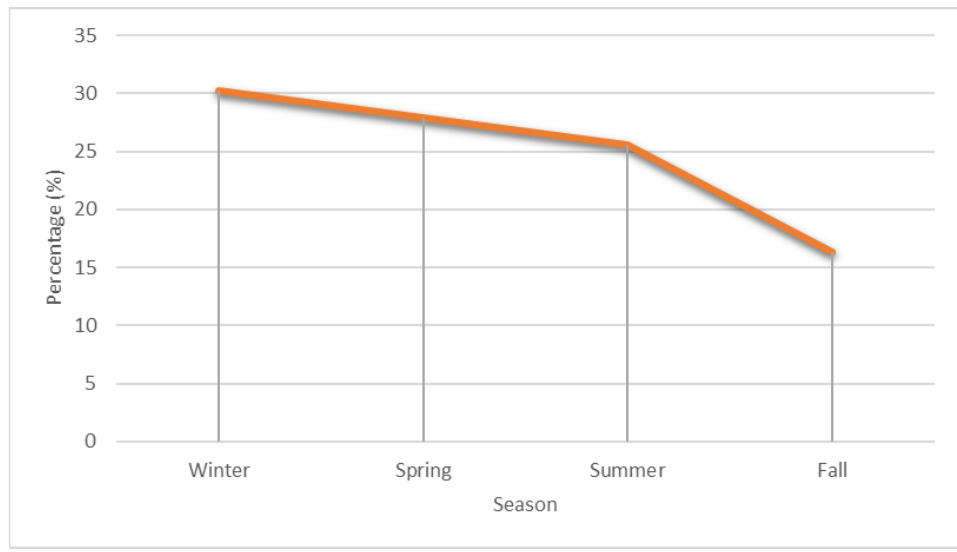
Figure 4. Seasonal incidence of odontogenic abscesses in the pediatric population. Antibiotic prophylaxis was not used in 61.3% of the included patients. In 76.7% of the included patients, the pathogens were unknown. Nevertheless, it should be mentioned that streptococci were observed in 9.3% of cases and staphylococci in 2.3% of cases. Before the occurrence of OA, previous tooth procedure was performed in 72.0% of patients ( p < 0.001). In 58.1% of patients, the causative teeth were lower molars, followed by upper molars (27.9%) and upper incisors (11.6%) (Figure 5). As for the localization of the OA, perimandibular (37.2%) and fossa canina (20.9%) were observed most frequently, followed by buccal (18.6%) and submucosal (16.3%) (Figure 5). The majority of patients were treated with antibiotics only (41.9%), followed by in- traoral incision (34.9%), extraoral incision (14%), and a combination of both methods (4.6%); 4.6% of patients were not treated (Figure 5). Most patients were without comor- bidities (93%), and no complications were observed in the pediatric group.